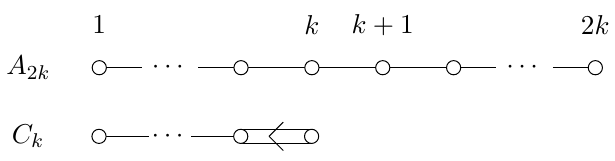
Figure 3 . Folding the Dynkin diagram A 2 k by sum yields the Dynkin diagram C k